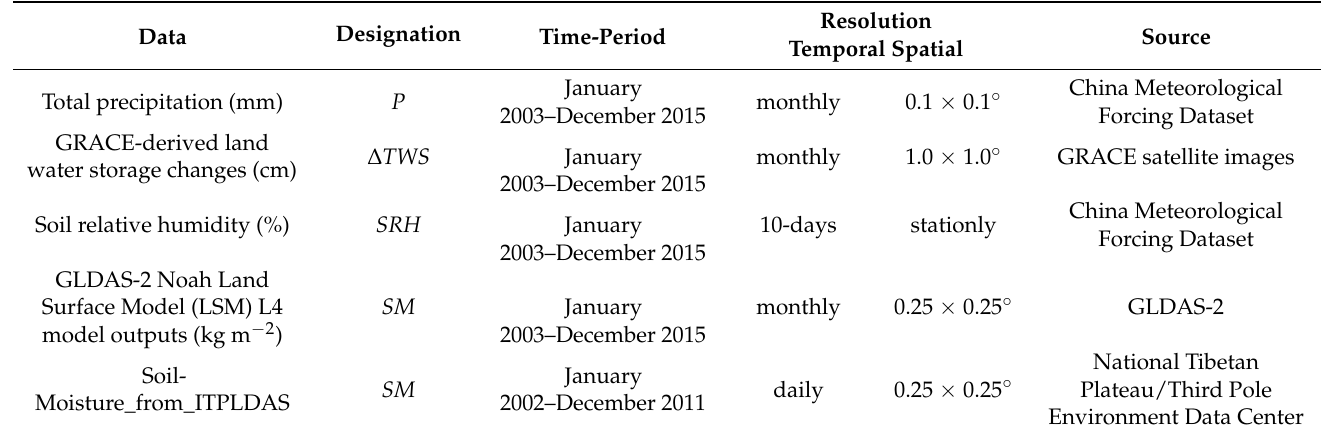
Table 2. Overview of the data used to reconstruct soil moisture in the